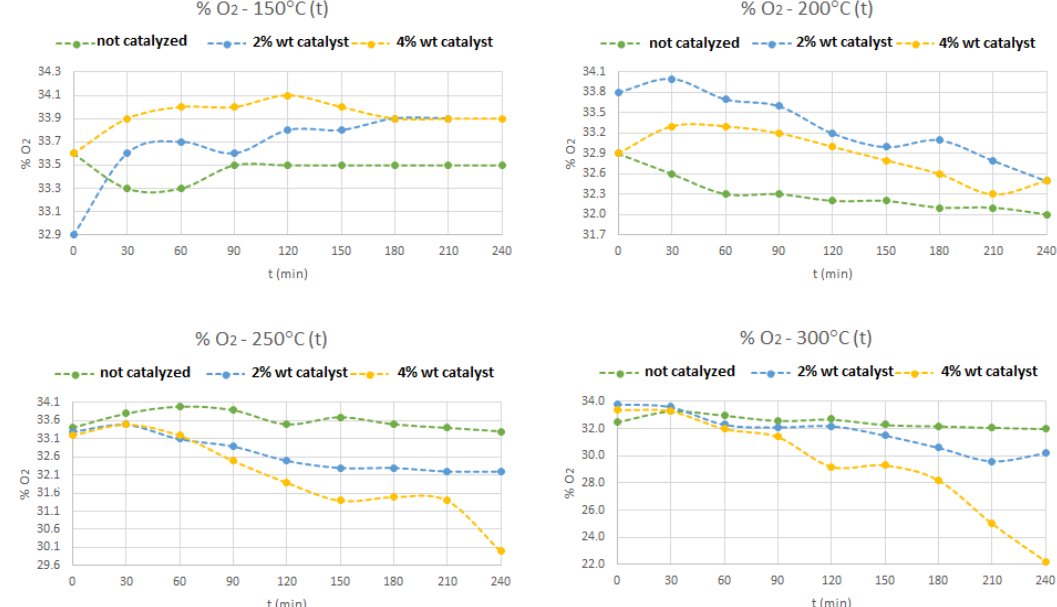
Figure 6. Comparison of the behavior of the percentage of oxygen in the gas produced over the test time for the synthesis gas production tests for different amounts of catalyst and temperatures (average values).